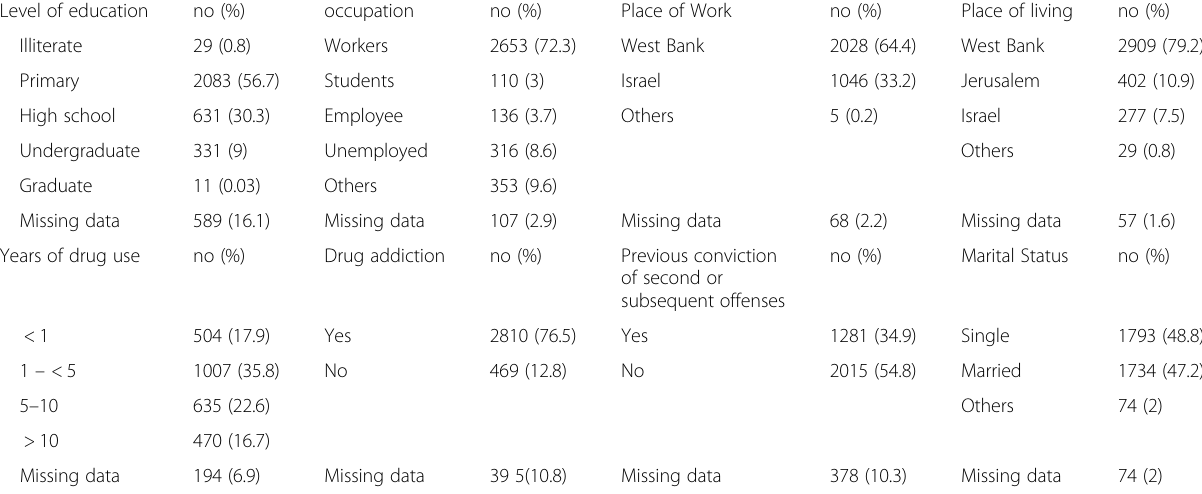
Table 2 Socio-demographic data of suspected persons captured with seized substances Level of education no